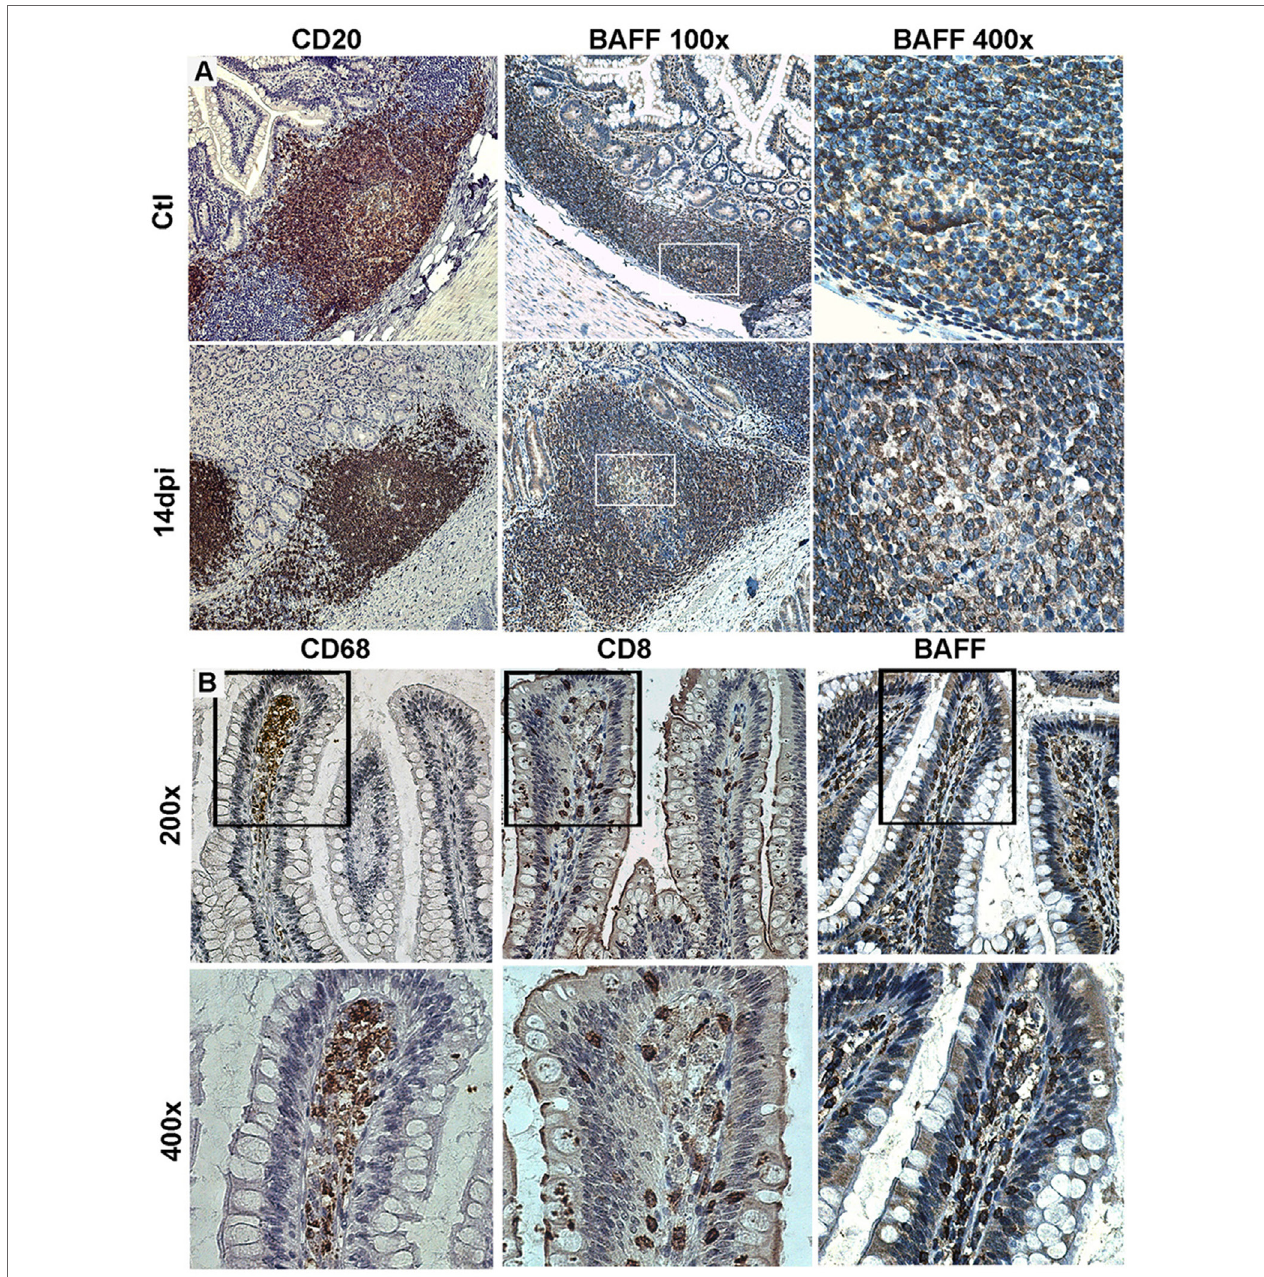
FiGURe 1 | Tissue expression of B-cell-activating factor (BAFF) in SIV-infected macaques. (A) Terminal ileum sections from control macaques (upper panel) and macaques infected for 14 days (lower panel) were stained with anti-CD20 (B-cells, left panels) or anti-BAFF (clone Buffy 2, middle and right panels) antibodies (Abs). Original magnification: 200 × for CD20, 100 × and 400 × for Buffy 2. (B) Terminal ileum sections with clear villi present were stained with CD68 (macrophages), CD8 (CD8 + and intraepithelial T-cells), and Buffy 2 (BAFF expression) Abs, respectively (original magnification 200 × ). Inserts from upper panels are shown in the lower panels (original magnification 400 × ). Reproduction authorized by